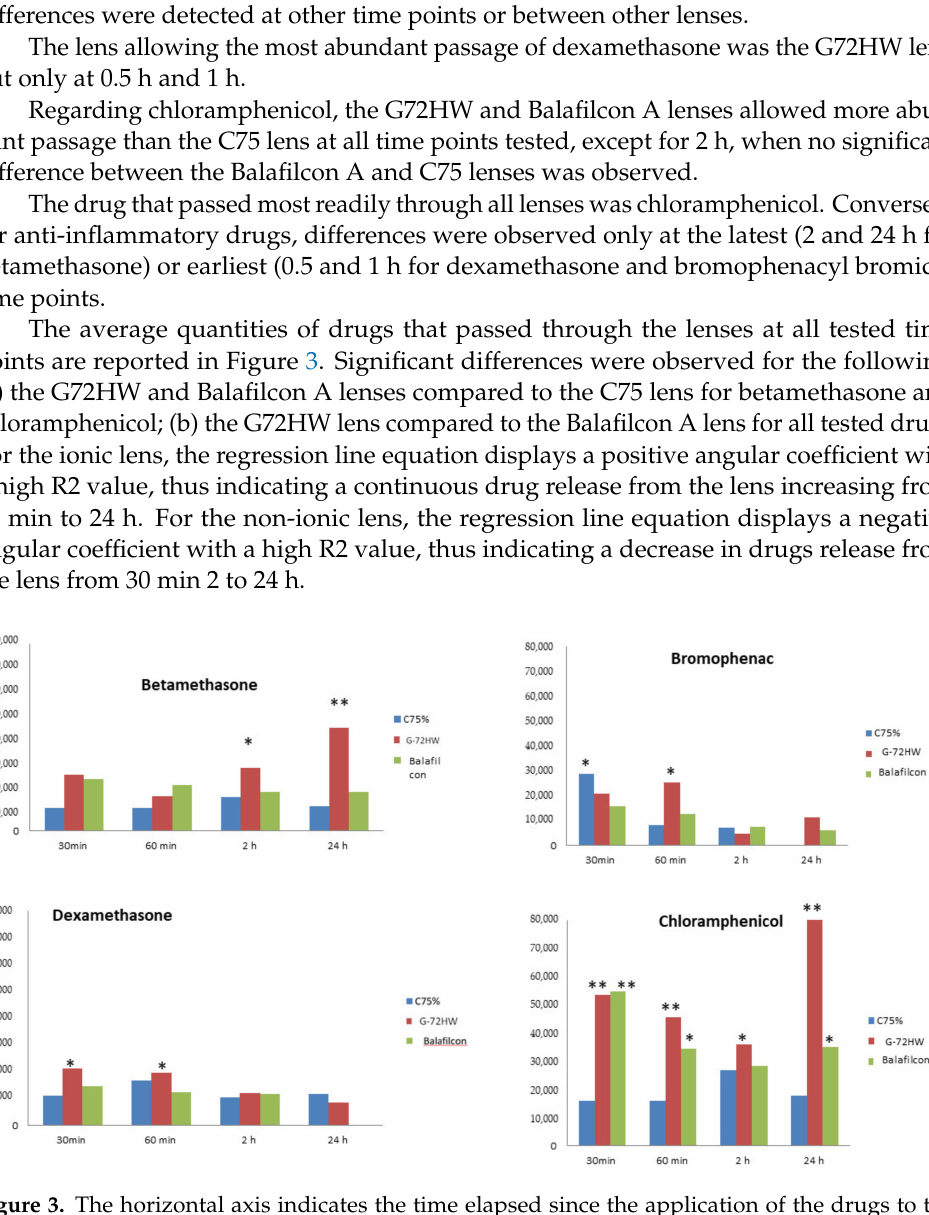
Figure 4. The diameter of the zone of inhibition around the chloramphenicol depot area (central white spot) was not different among the six experimental conditions tested.